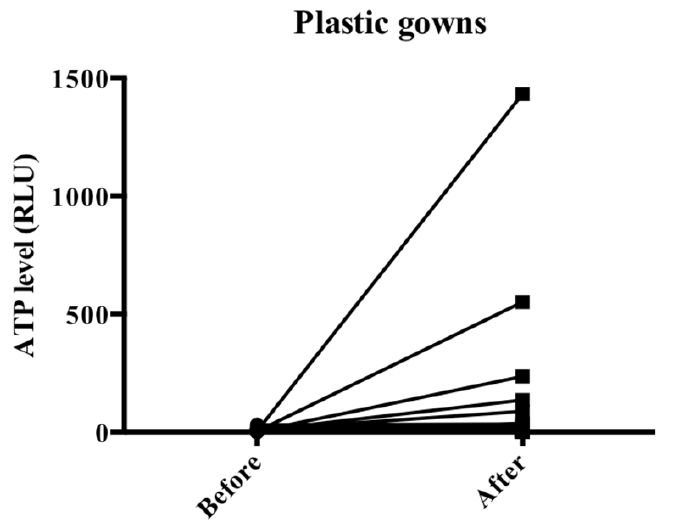
Figure 4. Changes in ATP concentrations with disposable plastic gowns. ATP, adenosine triphos-